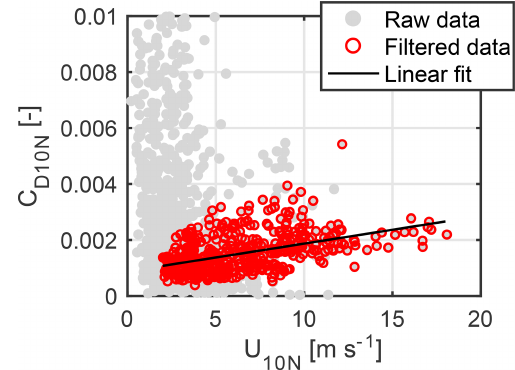
Figure 2. Raw and filtered (quality controlled) scatter data of drag coefficients ( C D10N ) as a function of neutral 10m height wind speed ( U 10N ). Figure 3. Drag coefficient as a function of neutral 10m height wind